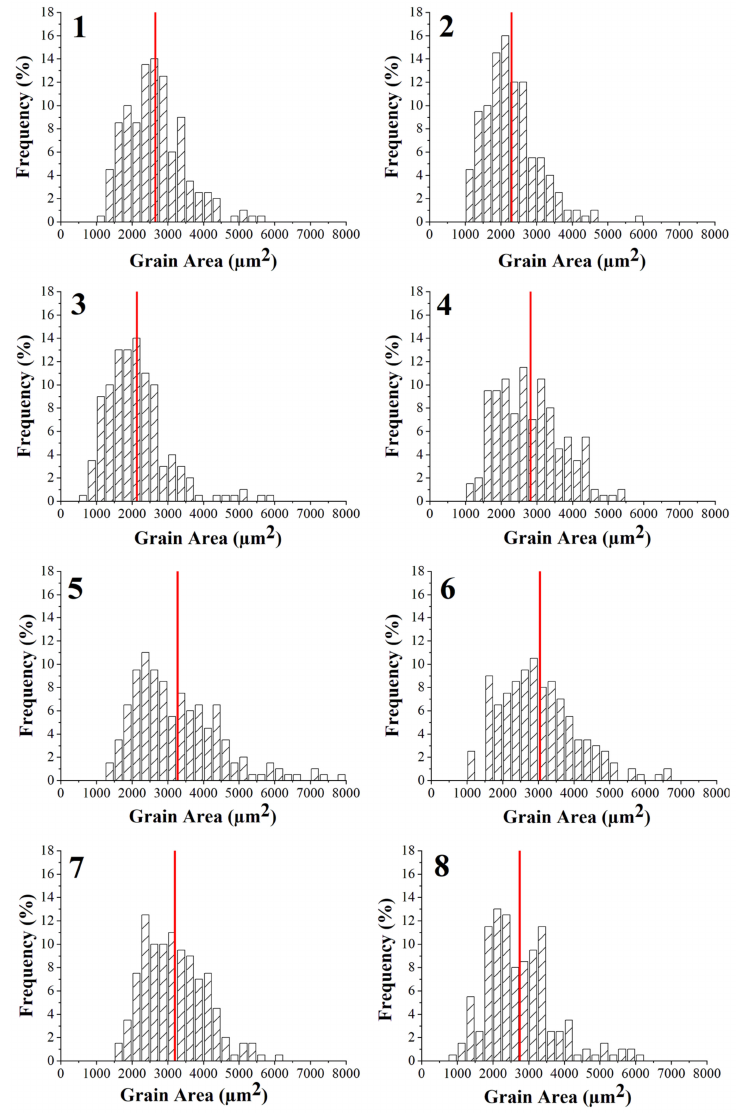
Figure 5. Grain area distributions of the eight printing configurations considered (the numbers at the top left of the graphs stand for the number of printing profiles investigated, as numbered in Table